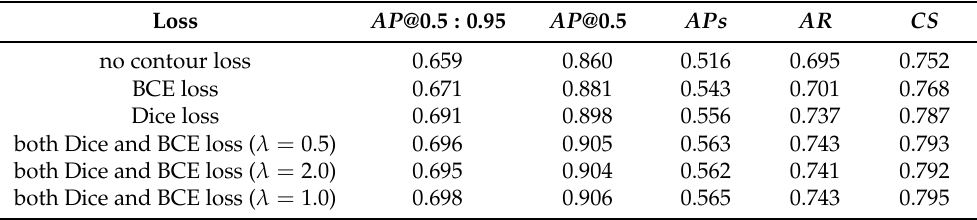
Table 6. Comparison results on different loss functions on WHU aerial image dataset. The best results are in bold.